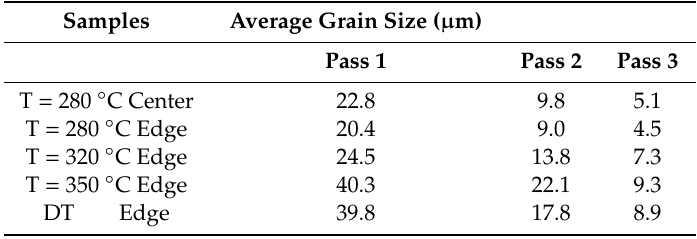
Table 1. The average grain sizes of the CEE-AEC samples at different temperatures. Samples